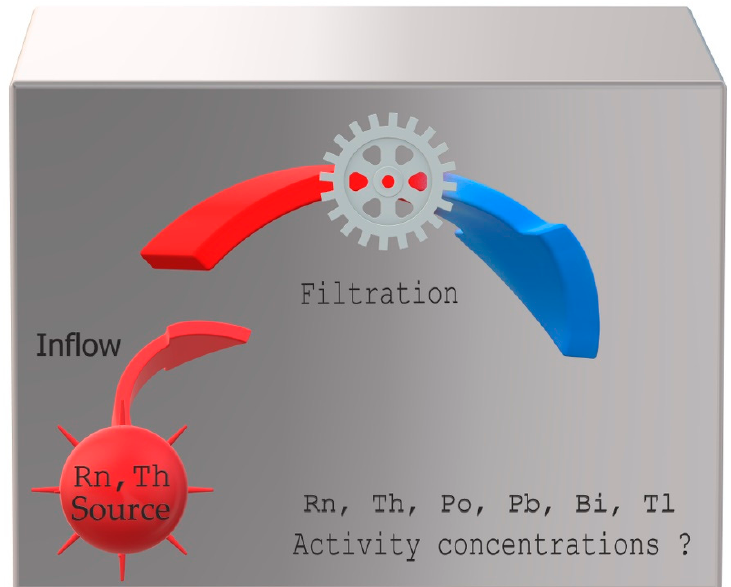
Figure 2. Basic assumptions of the model.